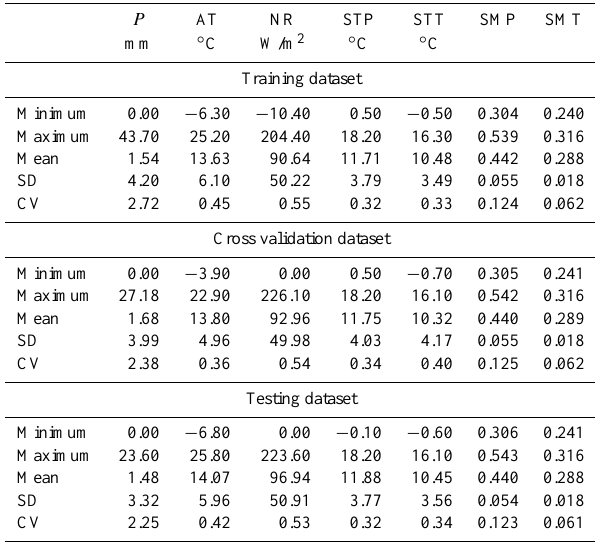
Table 2. Descriptive statistics of the daily peat and till moisture